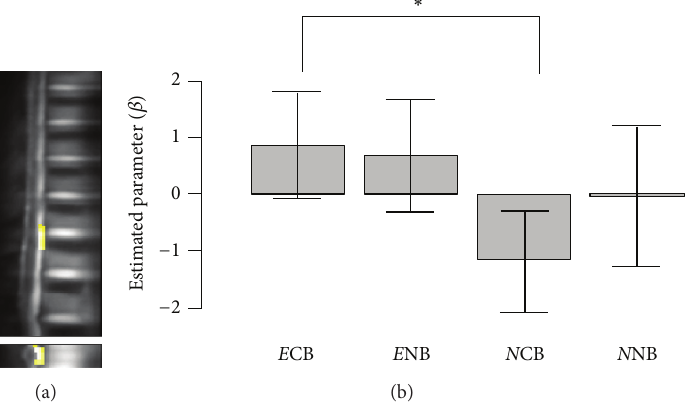
Figure 2: (a) Activation map across the regions of interest for experts; crosshair shows the peak activation voxel. For visualization the spinal canal is not excluded for this map. (b) Per-task response averaged across ten repetitions for one subject. Data was centered; error bars indicate SEM.